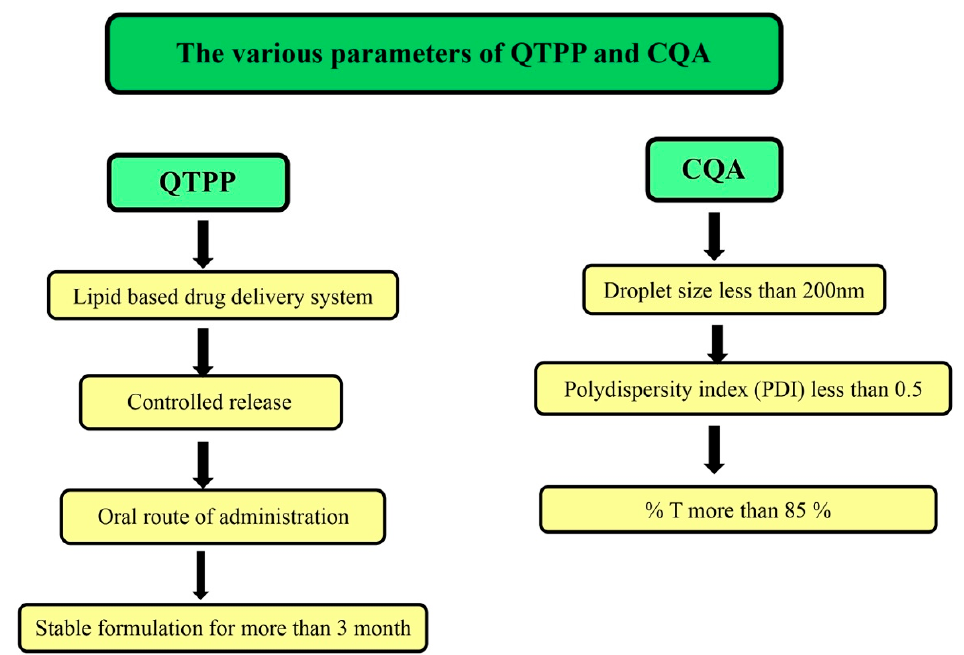
Figure 1. Parameters of QTPP and CQA for lipid-based drug